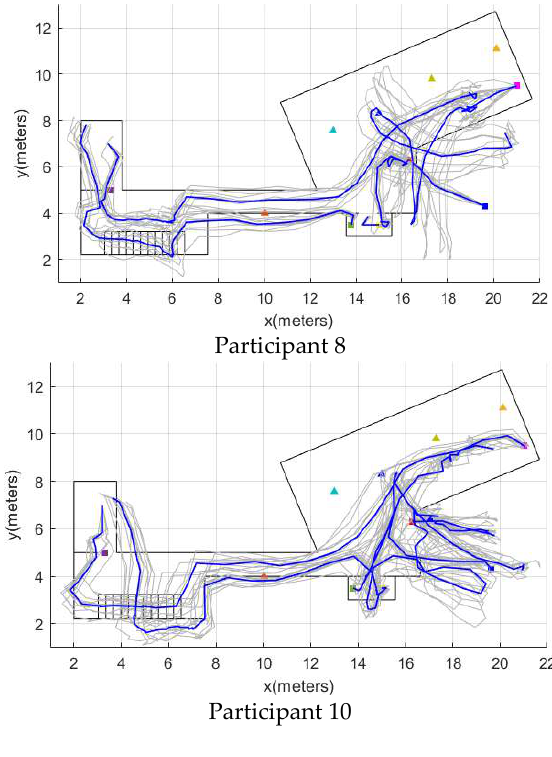
Figure A1. Indoor localization results (Older adults’ group, participants 1–6).